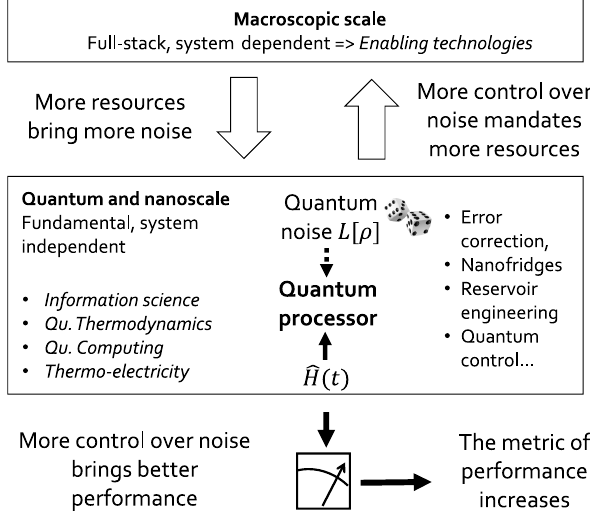
FIG. 1. Structure of the quantum energy initiative (QEI) for quantum computing. The performance of a quantum computa- tion is set at the fundamental level, and increases with the control over noise. More control over noise mandates more resources provided by the macroscopic level. These macroscopic resources bring more noise at the fundamental level. Optimized resource management relies on the alliance between different fields of expertise. This alliance defines the QEI called in the present